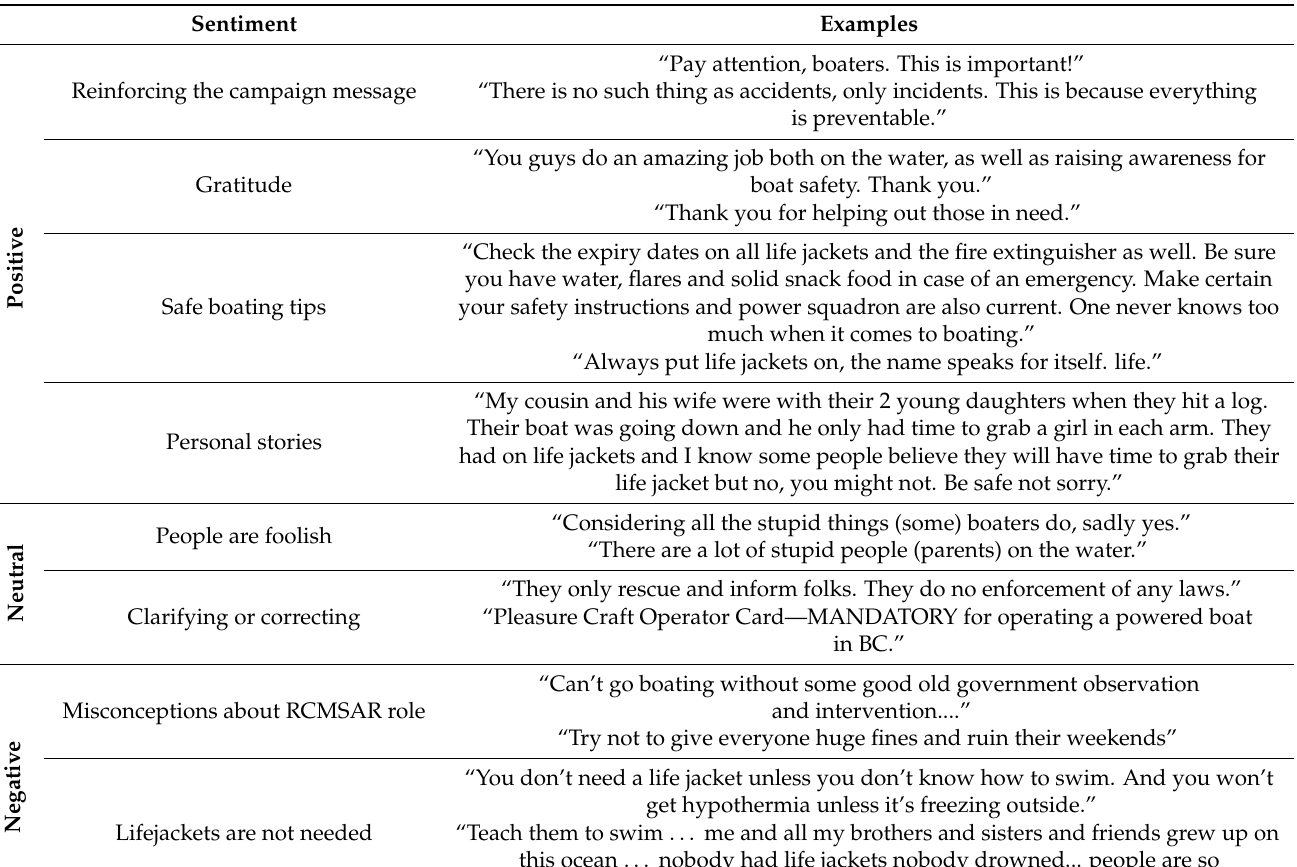
Table 2. Examples of positive, neutral and negative user